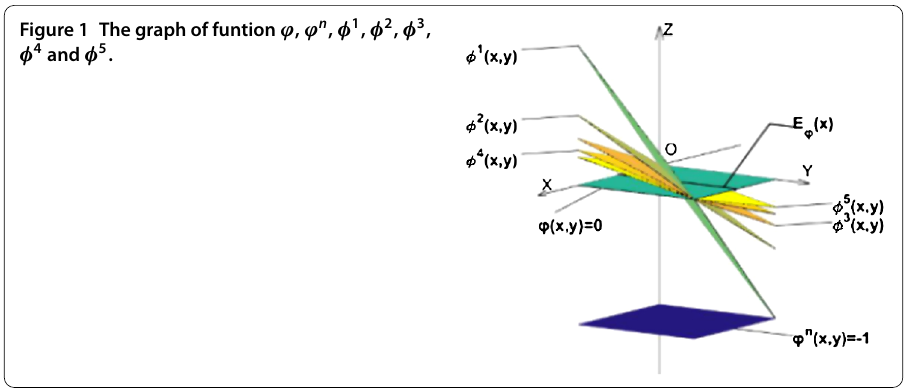
Figure 1 The graph of funtion ϕ , ϕ n , φ 1 , φ 2 , φ 3 , φ 4 and φ 5